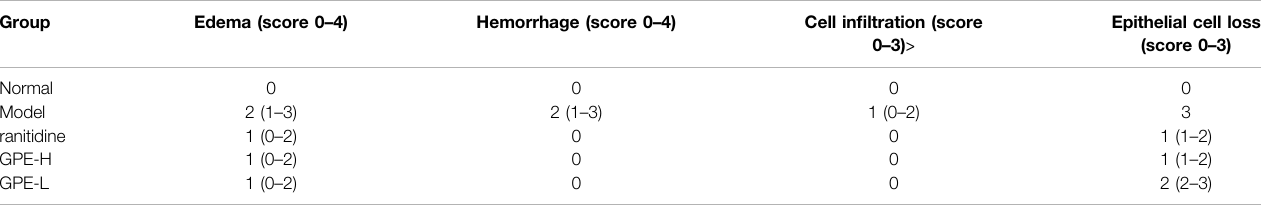
TABLE 4 | The pathological changes in gastric mucosa induced by ethanol/HCl in mice. Group